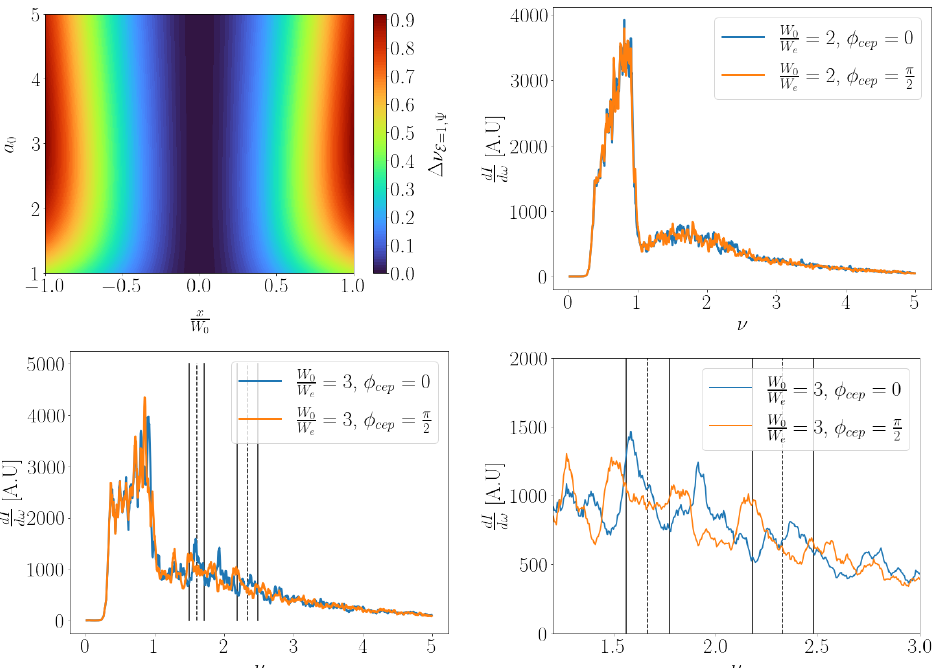
Figure 6. ( Top left ): Broadening of the spectrum due to different values of a 0 that electrons experience depending on their transverse position as compared to an electron traveling on-axis. The value of ∆ ν E = 1, Ψ needs to be small in order to see the effect of φ cep in the spectrum. ( Top right ): spectrum = 2, N c = 5, W = 45 µ m and electron = 2. Laser parameters are a within ϑ = 1 when W 0 0 0 W e 10 γ = 10 − 3 . The differences in the intensity electrons parameters (cid:101) = 10 − 6 mm mrad, γ = 2, σ γ γ experience dominates over the φ cep dependency. ( Bottom left ): same simulation parameters but W 0 = 3. The frequency shift due to φ cep is visible. The black dotted lines indicate the peak for φ cep = 0 W e (Equation (6)) and the solid black lines for φ cep = π (Equation (8)) for the fifth and seventh harmonics. 2 ( Bottom right ): same as left zoomed in on a smaller frequency range to show the dependency